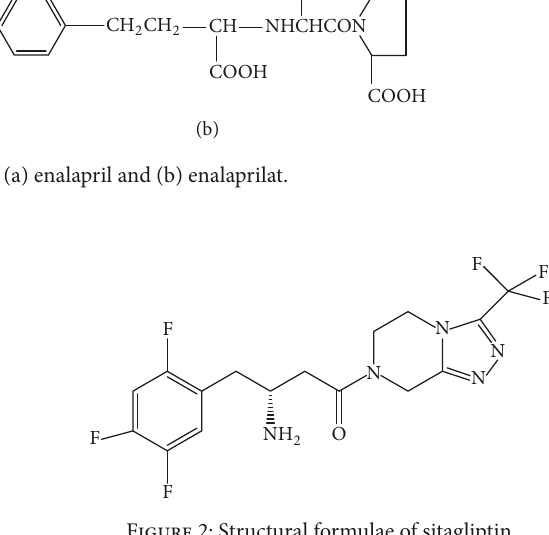
Figure 2: Structural formulae of